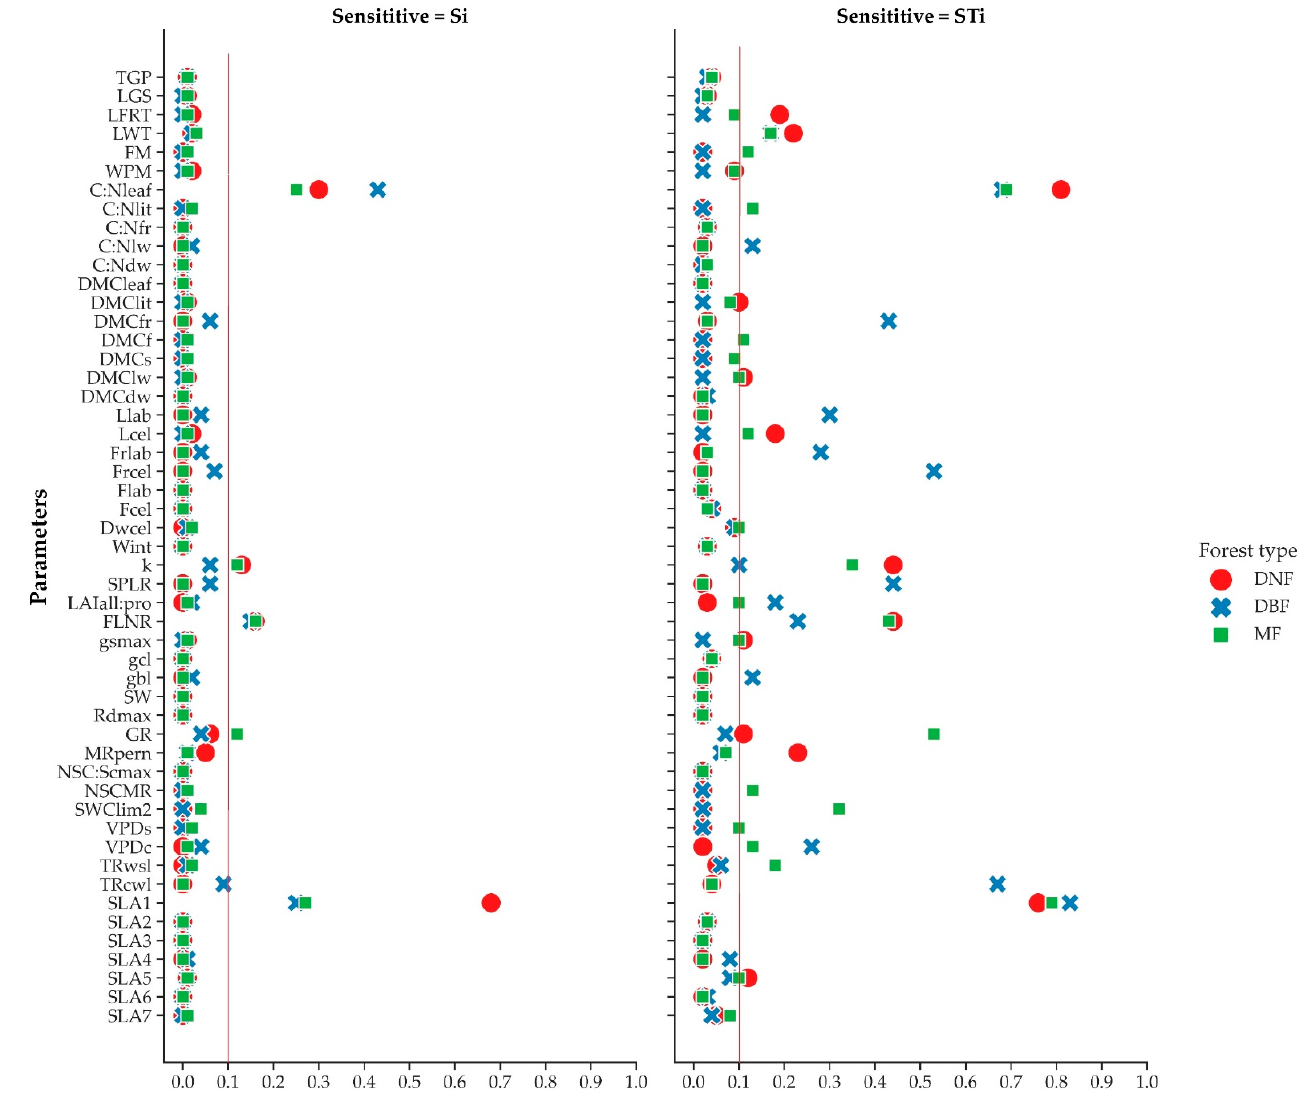
Figure 4. First-order Sensitivity Index (Si) and Total Sensitivity Index (STi) for GPPs of different forest